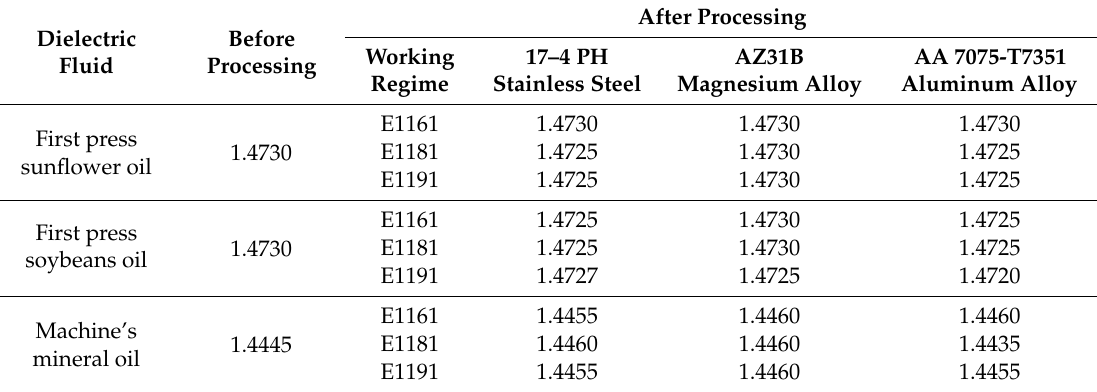
Table 9. Refractive indices of the used dielectric fluids.